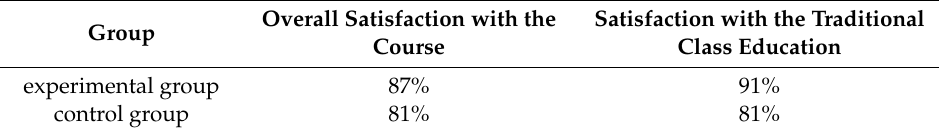
Table 1. Overall satisfaction with the course of the experimental group and the control